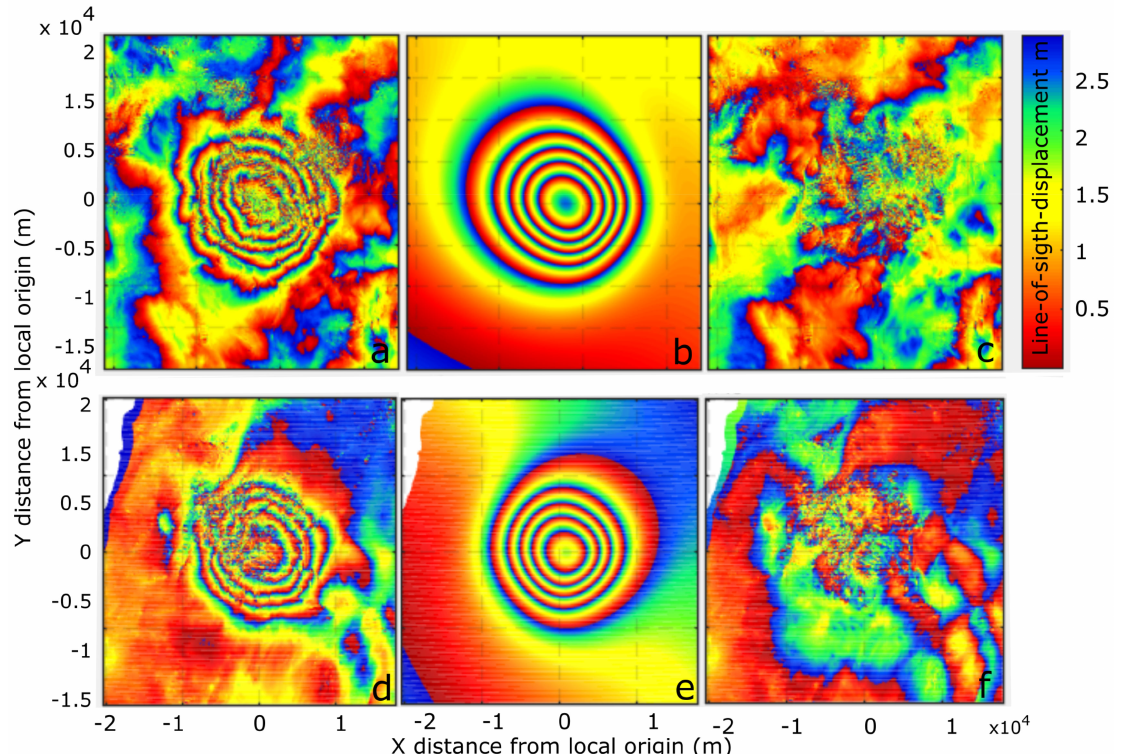
Figure 9. Images ( a ) and ( d ) correspond to the ascending and descending Sentinel-1 interferogram products, respectively, for the May 2017 to March 2018 period. Images ( b ) and ( e ) correspond to the modeling results from GBIS software, using a rectangular dipping source [76]. Images ( c ) and ( f ) are the corresponding